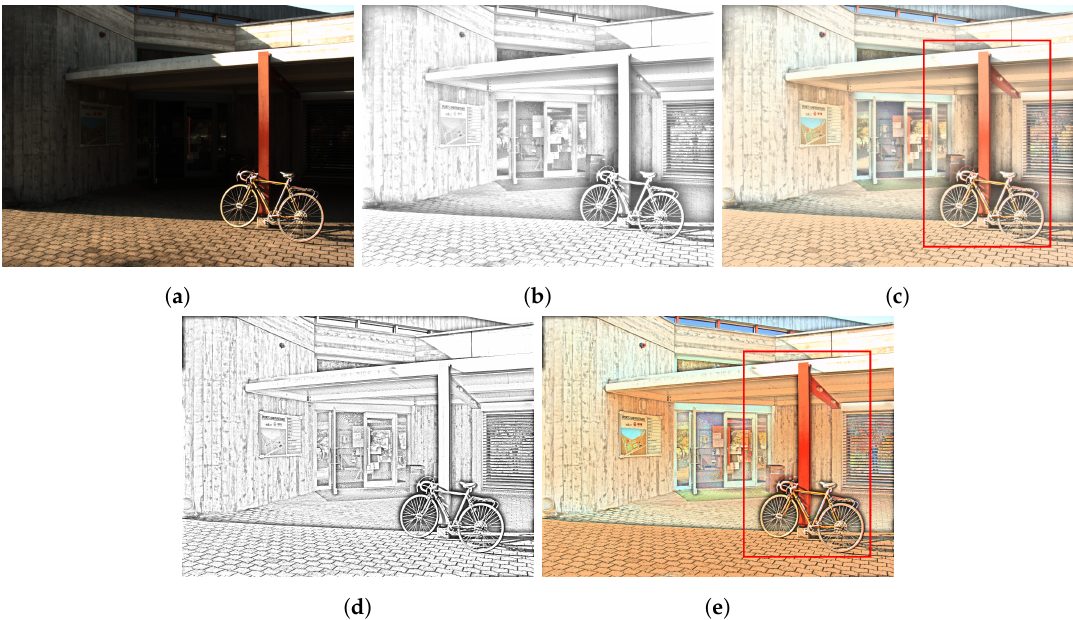
Figure 10. Comparison of high contrast image reconstruction: ( a ) Original test image; ( b ) Reflectance using [16] Retinex model; ( c ) Image enhancement image using [16] Retinex model; ( d ) Reflectance using SVD-CSC general dictionary; ( e ) Image enhancement image using SVD-CSC general